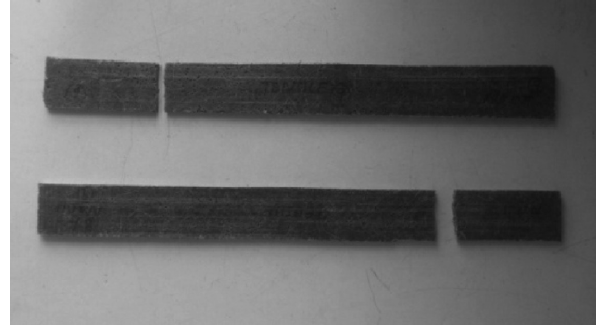
Figure 8 Specimen for after tensile test (2% NaOH and 25-mm length).